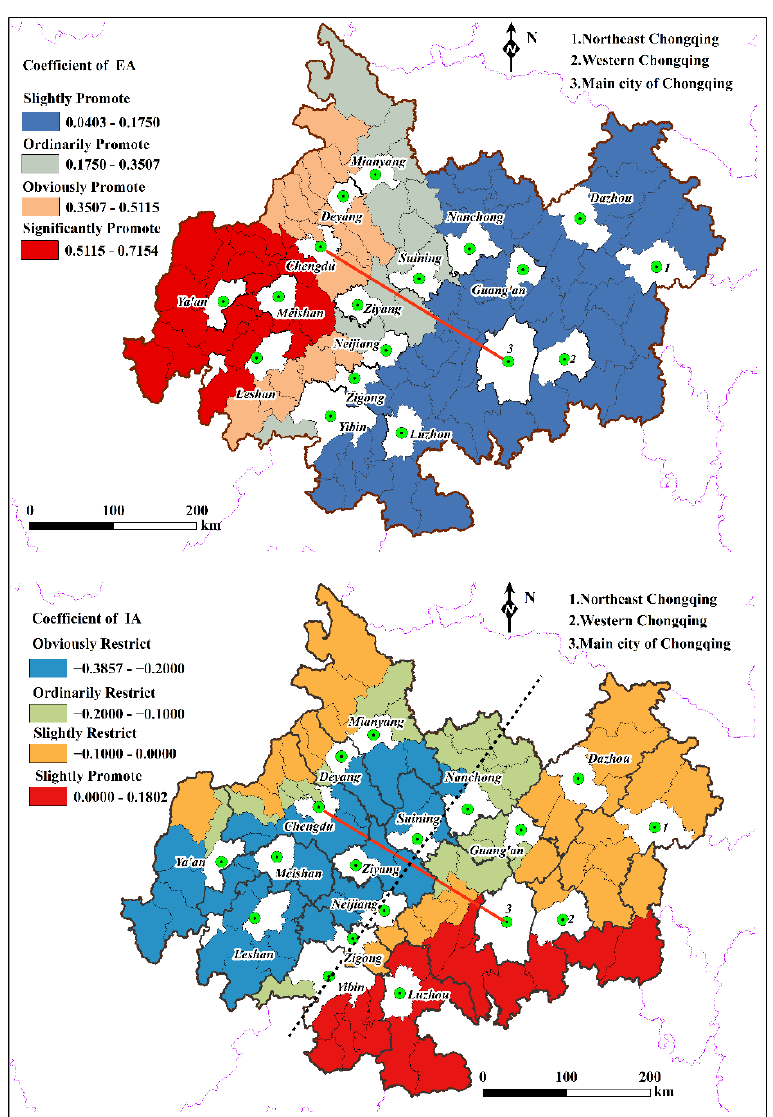
Figure 8. Spatial distribution of the effect of accessibility on anti-poverty efficiency in 2020. Notes: the coefficients of EA and IA were obtained by GIS using a geographically weighted regression model. R 2 = 0.4863, AICC = 203.86, passing the fitting effect test of 2.5 times standard deviation.